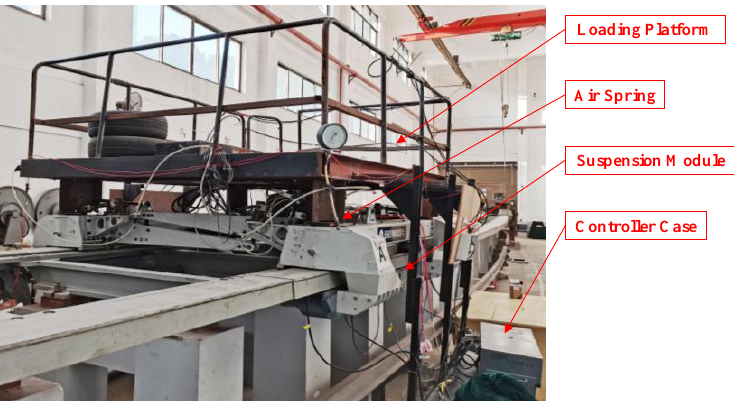
Figure 15. The single-bogie experimental platform of the suspension system. Table 2. Relevant parameters of the suspension system.